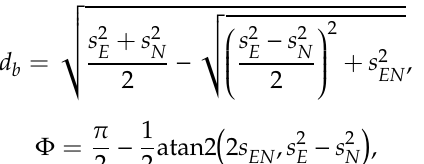
Figure 3. Horizontal protection level and alert limit.